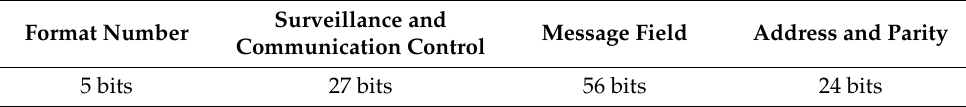
Table 2. Mode S Data Block Surveillance and Communication Interrogation and Reply— Communication-A and Communication-B Message Format [29].